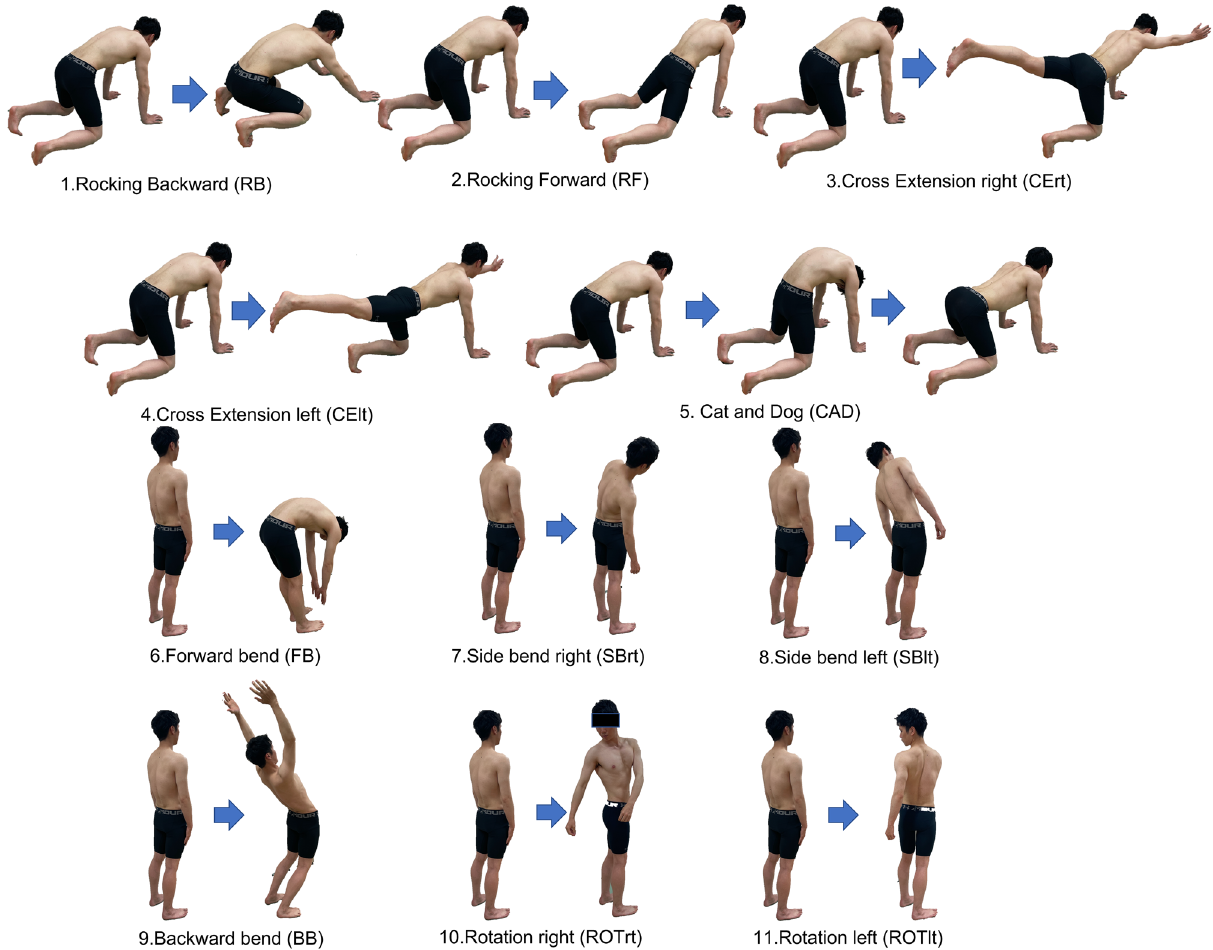
Figure 1. Eleven trunk movement and stability motor tasks. (1) Rocking backward (RB), (2) rocking forward (RF), (3) cross extension right (Cert), (4) cross extension left (Celt), (5) cat and dog (CAD), (6) forward bend (FB), (7) side bend right (SBrt), (8) side bend left (SBlt), (9) backward bend (BB), (10) rotation right (ROTrt), (11) rotation left